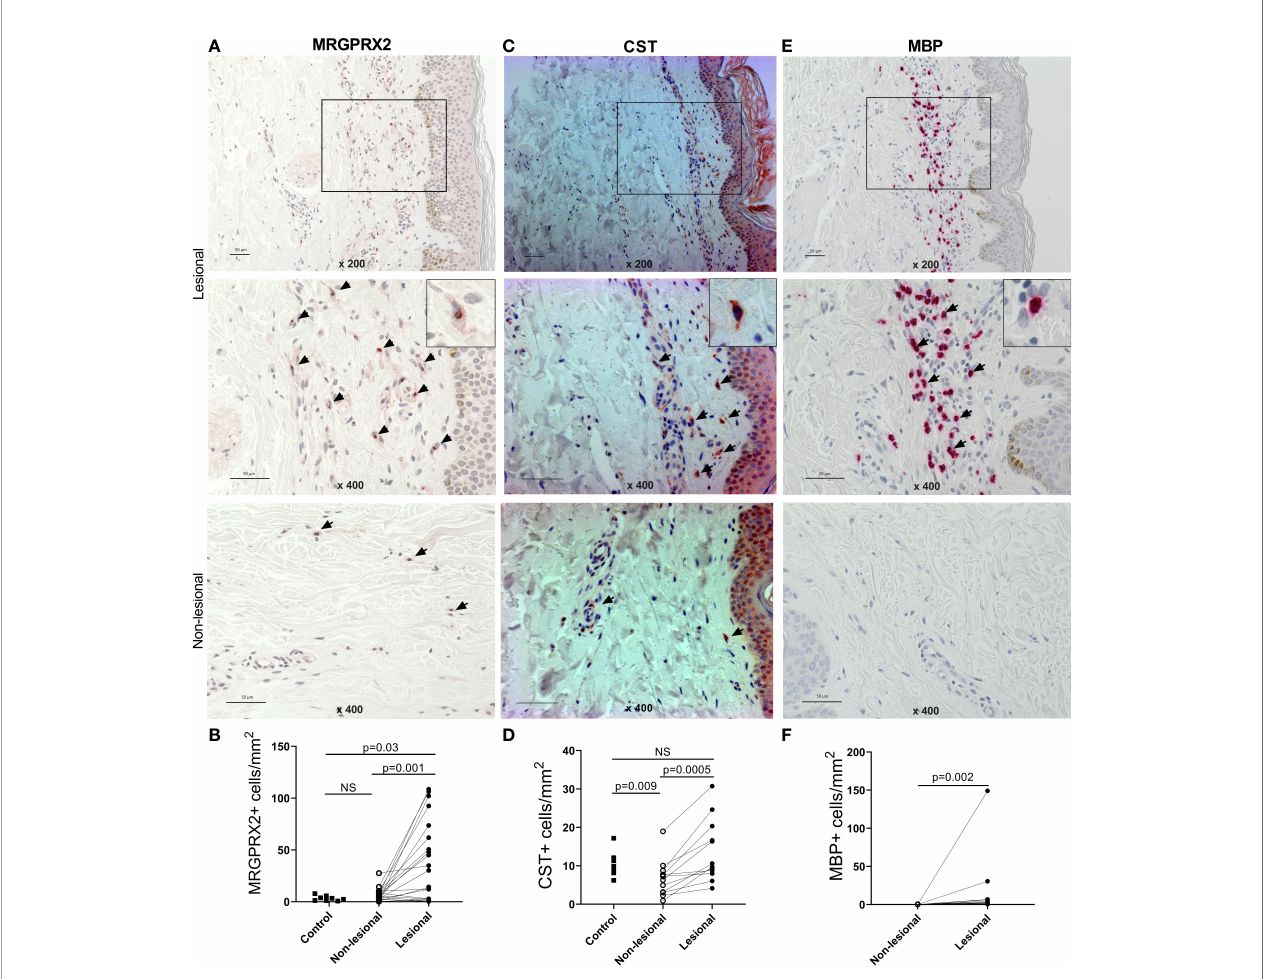
FIGURE 1 | The number of MRGPRX2+, CST+, and MBP+ cells is increased in the lesions of patients with indolent systemic mastocytosis. Immunohistochemical staining of (A) MRGPRX2, (C) CST, and (E) MBP in the lesional and non-lesional skin of patients with ISM #6, #10, and #13, respectively. ×200 magni fi cation of upper picture; ×400 magni fi cation of all other pictures (expressing cells are shown by arrows). Bar = 50 µm. Number of (B) MRGPRX2+ cells, (D) CST+ cells, and (F) MBP+ cells in lesional and non-lesional skin of patients with ISM and skin of healthy controls. p < 0.05 was considered signi fi cant. The number of patients and controls as well as means/medians are summarized in the Table 2 . CST, cortistatin; ISM, indolent systemic mastocytosis; MBP, major basic protein; NS, non- signi fi